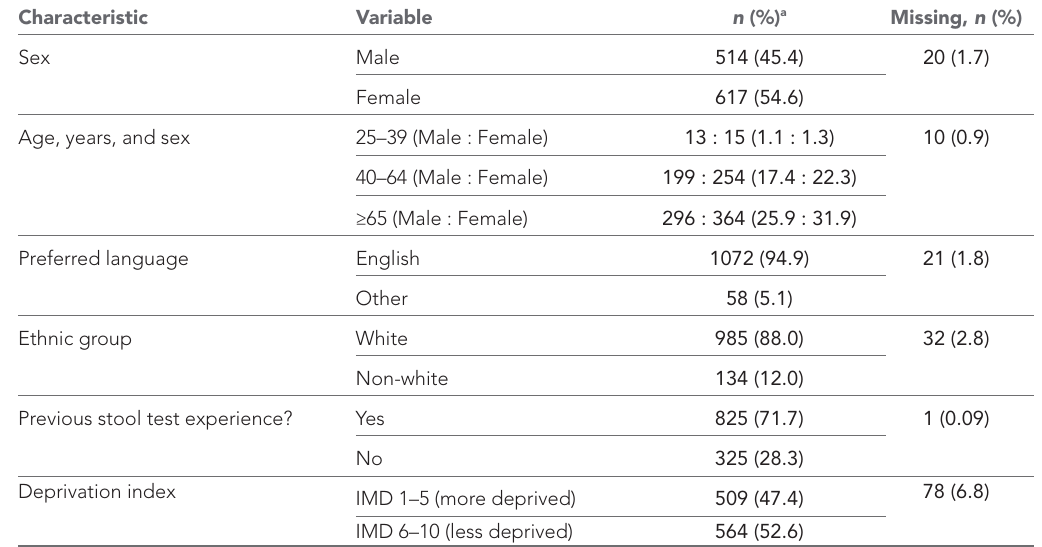
Table 4 Demographic characteristics of patients who responded to questionnaire